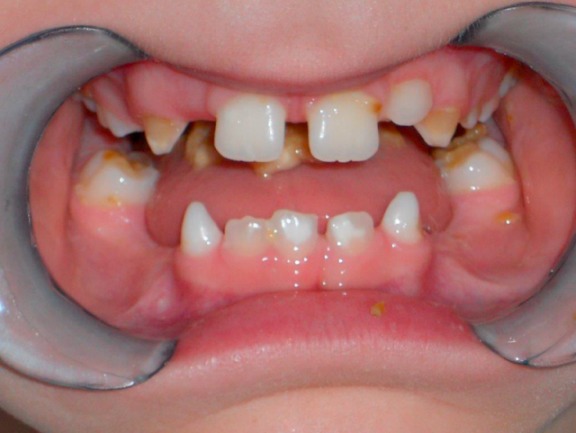
Dysphagia with disorders of the oral phase. Parts of the bolus are transported into the oral vestibule in an anterior and lateral direction because of a protrusion of the tongue. Malocclusion, dental enamel defects.